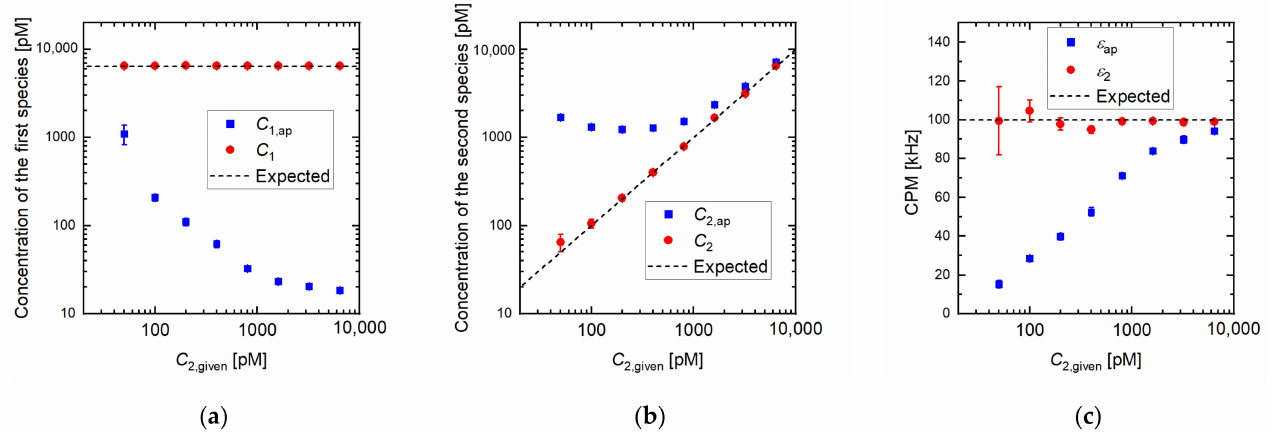
Figure 1. Dependency of the given concentration of the second species. ( a ) Dependency on the measured concentration of the first species C 1 ; ( b ) dependency on the measured concentration of the second species C 2 ; ( c ) dependency on the measured CPM. Error bars show the standard errors ( n = 10).